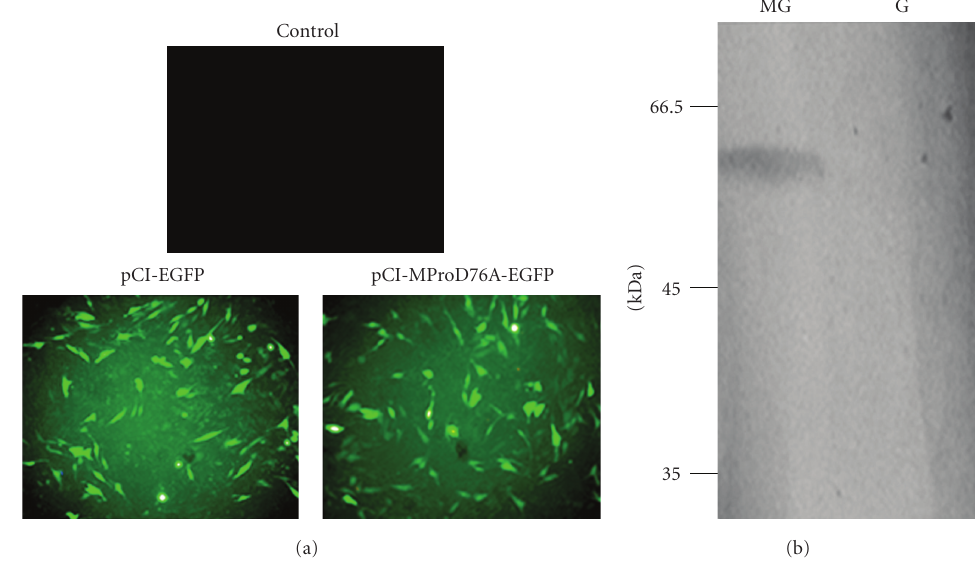
Figure 2: Expression of MProD76A-EGFP and EGFP in transiently transfected C2C12 cells. (a) Fluorescent microscopy of C2C12 cells transfected with pCI-MProD76A-EGFP or pCI-EGFP and untransfected control. (b) Western blot analysis of MProD76A-EGFP or EGFP secreted into the conditioned media. MG, pCI-MProD76A-EGFP-transfected cells; G, pCI-EGFP-transfected